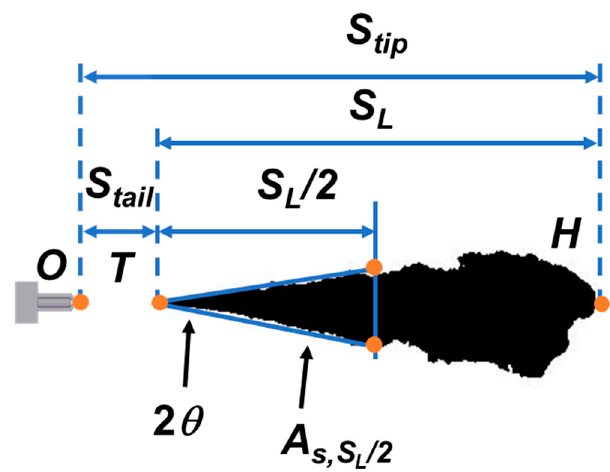
5 of 28 Figure 2. Visualization of the experimental system setup for determining the spray characteristics. 1: Constant volume chamber; 2: xenon lamp; 3: high-speed CMOS camera; 4: pinhole; 5: concave mirror. In order to study the tail penetration of the split-injected fuel sprays, it is necessary to first define the spray characteristics. Figure 3 illustrates the definitions of the spray characteristics. α represents the spray angle. A s is the definition of spray area. As S L /2 is defined as the half length of the entire spray, A s,SL/2 is the definition of the upper spray area at the half spray length. The various